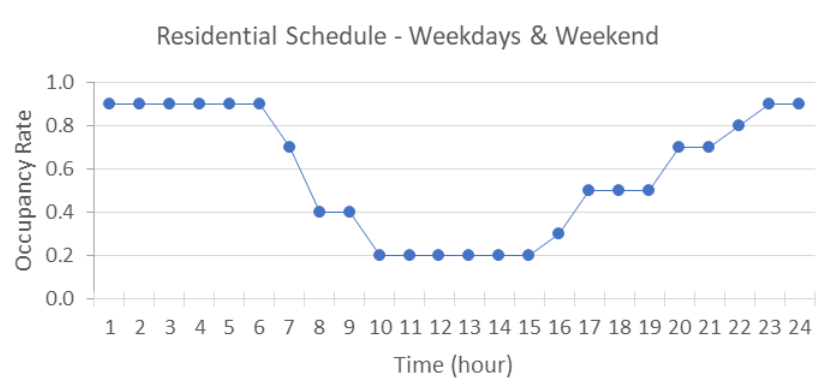
Figure 3. Occupancy schedule.